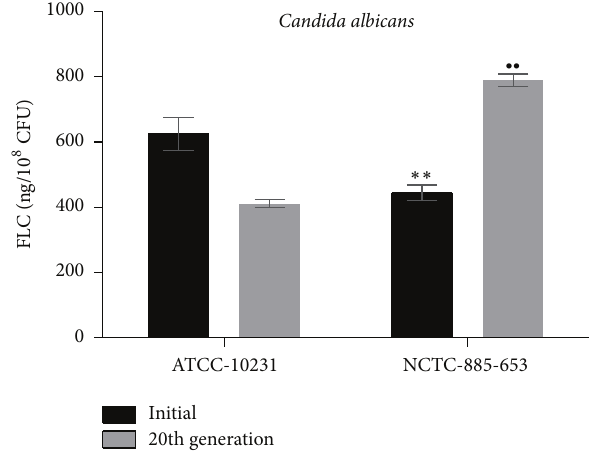
Figure 4: Intracellular concentrations of FLC for two different C. albicans strains long-term cultivated in the presence or absence of FLC. All data represent mean ± SD (error bars) for 𝑛 = 12 , for each fungal culture, and are significantly different comparing initial Candida albicans NCTC - 885-653 and Candida albicans ATCC-10231 strains at ∗∗ 𝑃 < 0.003 and comparing 20th generation of Candida albicans NCTC-885-653 and Candida albicans ATCC-10231 strains at ∙∙ 𝑃 < 0.005 , respectively.